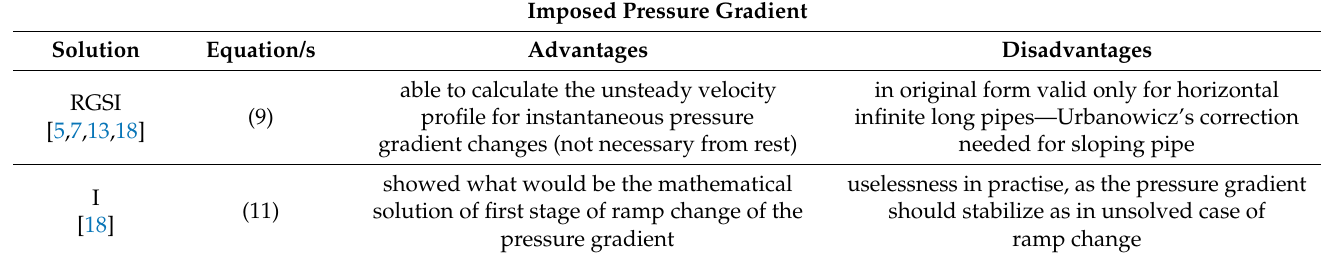
Table 2. Short summary of the reviewed analytical solutions valid for laminar accelerating pipe flow (except TULF